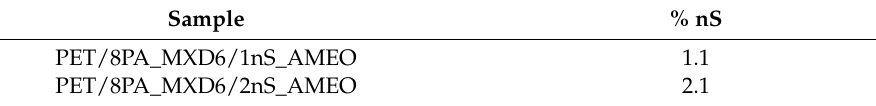
Table 4. Percentage of nanosepiolite present in the